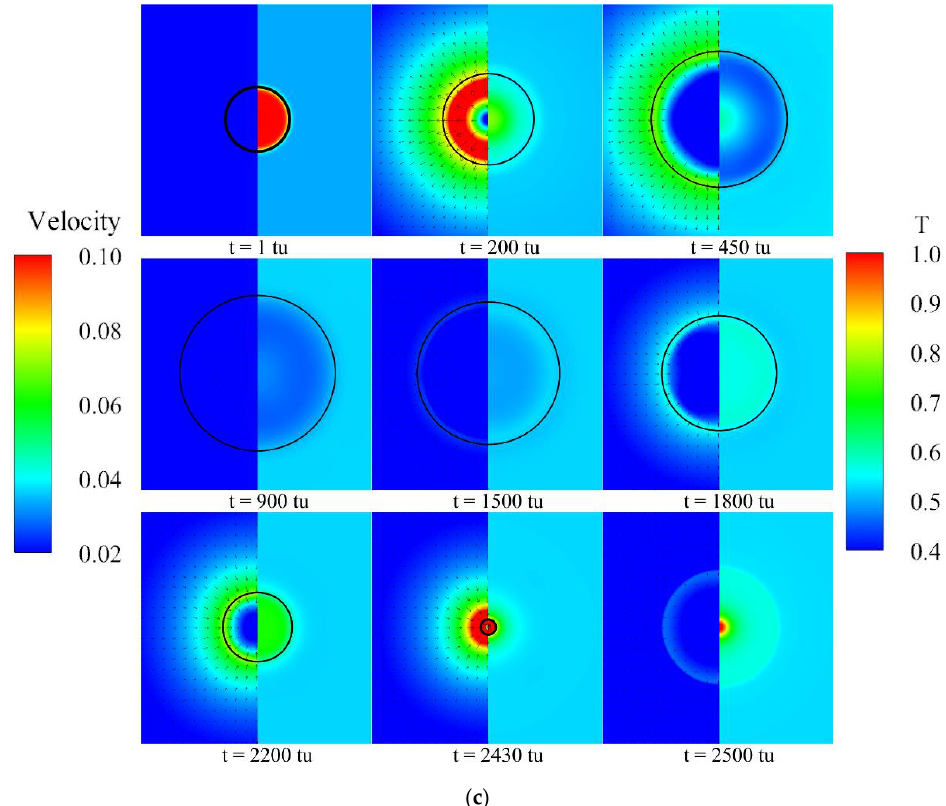
Figure 3. The evolution of single cavitation bubble in an infinite domain. ( a ) Experimental results [55], reproduced or adapted from adequate reference, with permission from publisher Elsevier, 2021; ( b ) density field obtained by the DDF-LBM model; ( c ) velocity and the temperature fields by DDF-LBM model.